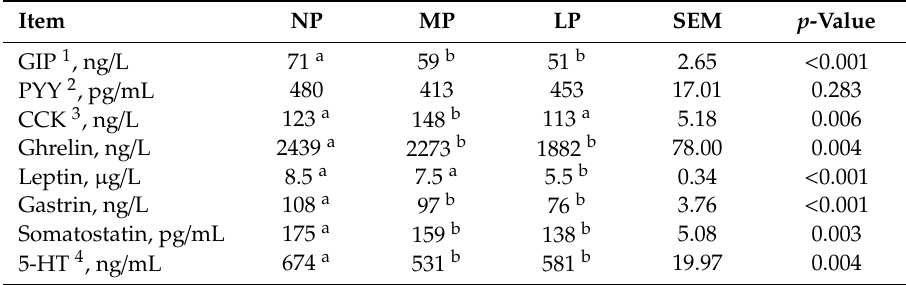
Table 5. E ff ect of dietary protein level on gut hormones of